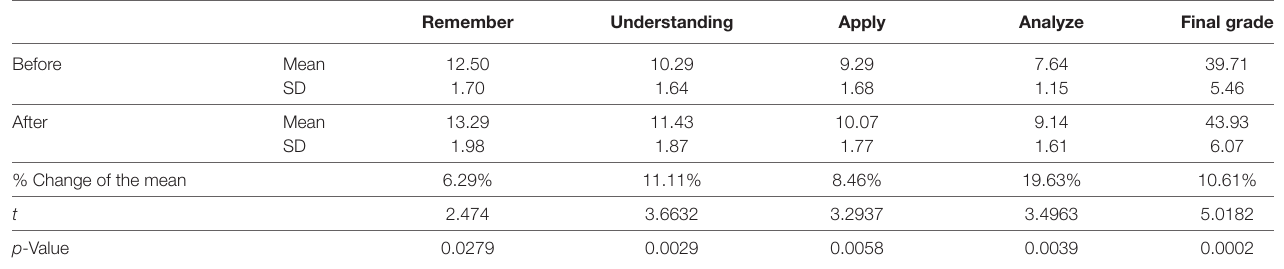
TaBle 4 | Students with low achievement in mathematics.